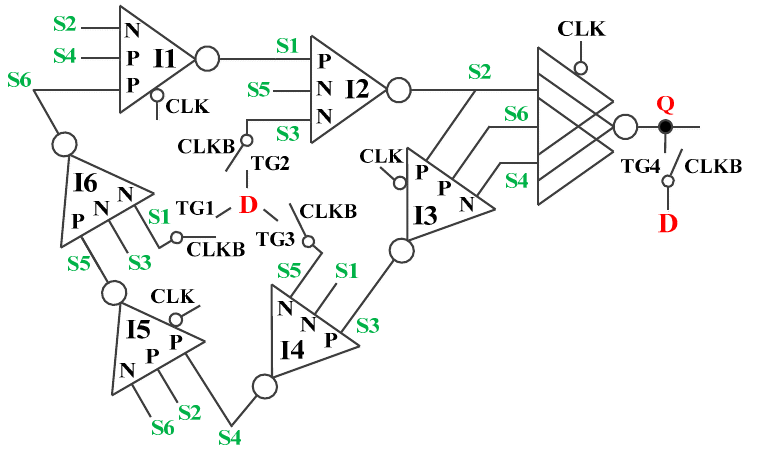
Figure 3. Schematic of the proposed HLDUT latch.